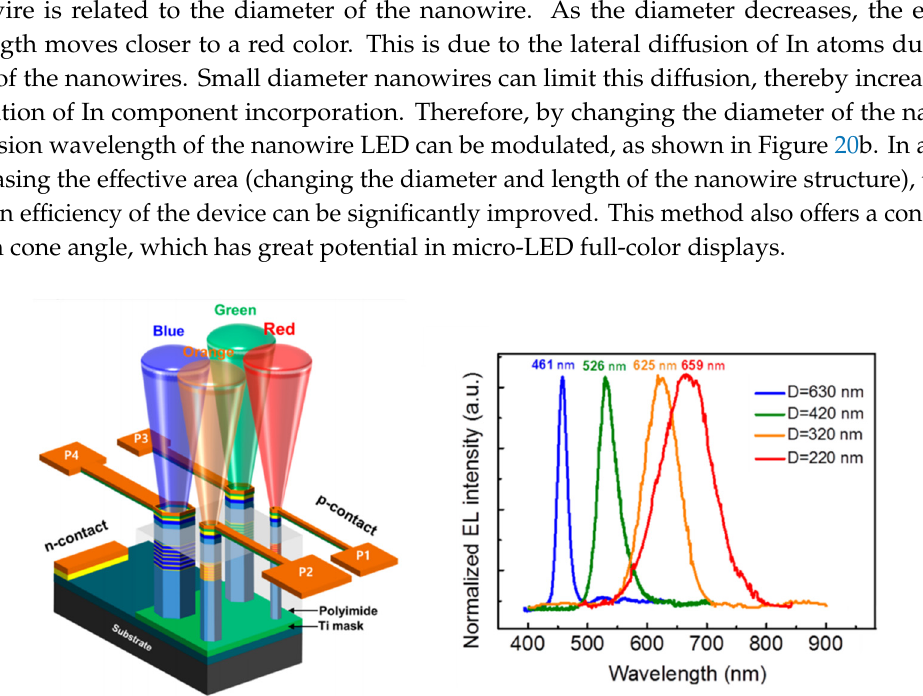
Figure 19. ( a ) Shell/core nanowire LED structure and EL images driven by different external voltages. Reproduced from [116], with permission from John Wiley and Sons, 2011; ( b ) InGaN/GaN dot-in-a- wire LED structure. Reproduced from [117], with permission from Institute of Physics, 2011. All rights reserved.